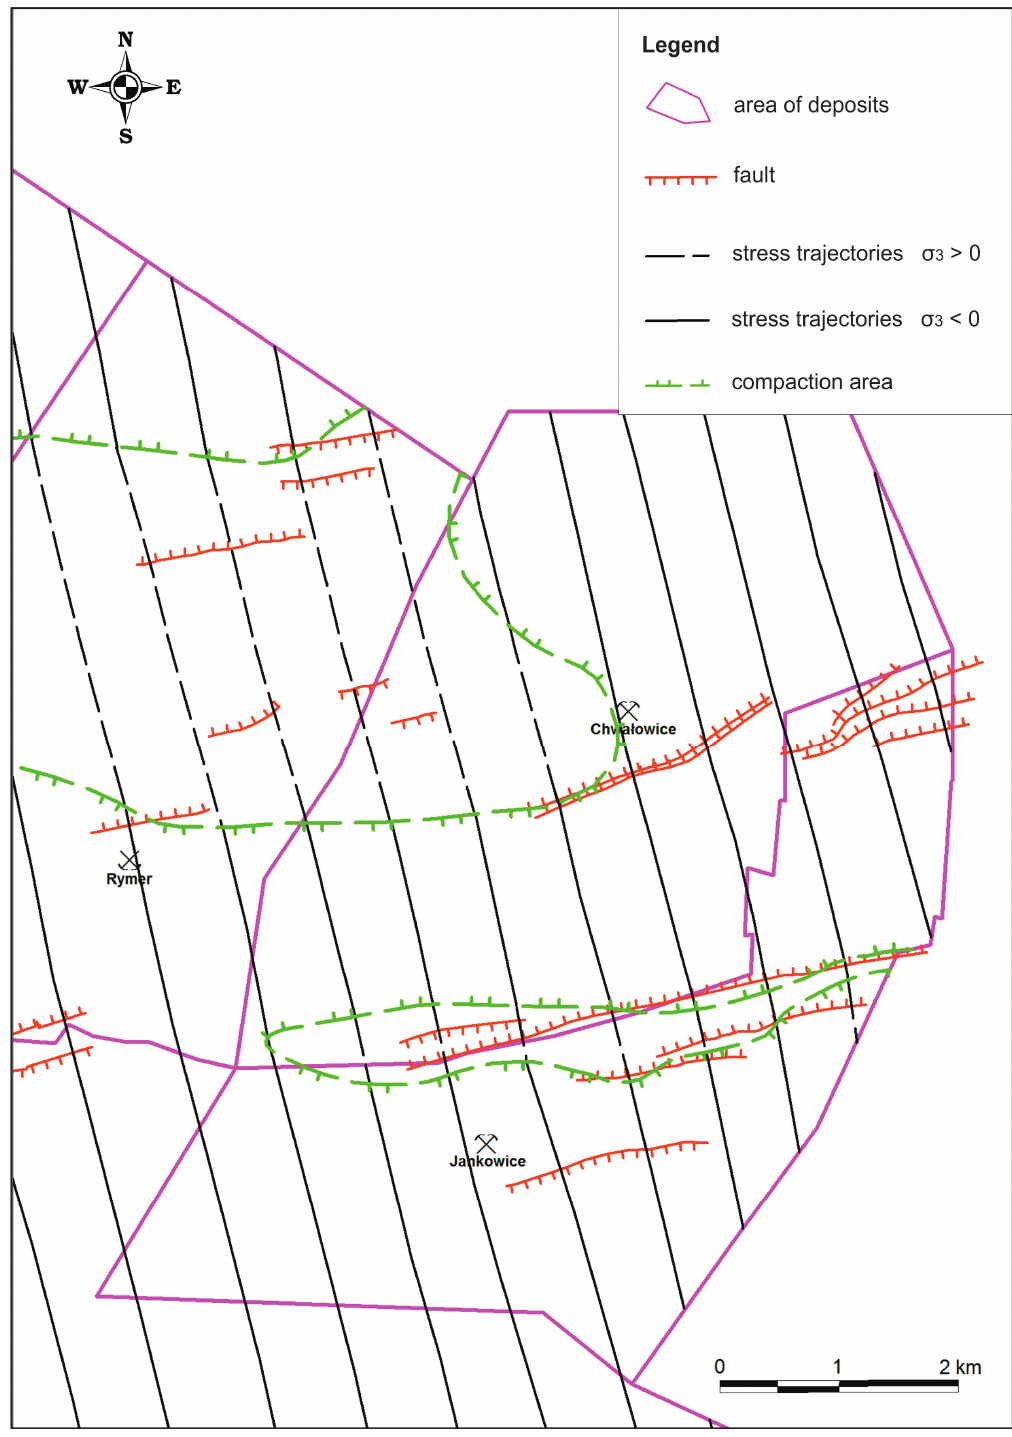
Fig. 3. Fragment of the map showing the tectonics stress field causing fracturing of system